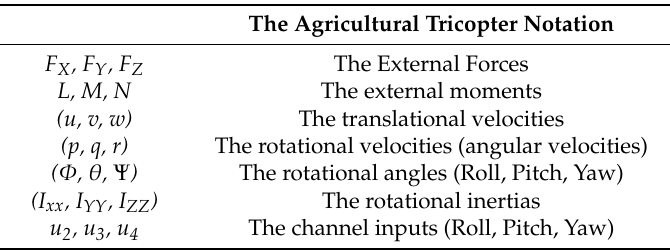
Table 2. The agricultural tricopter notation.